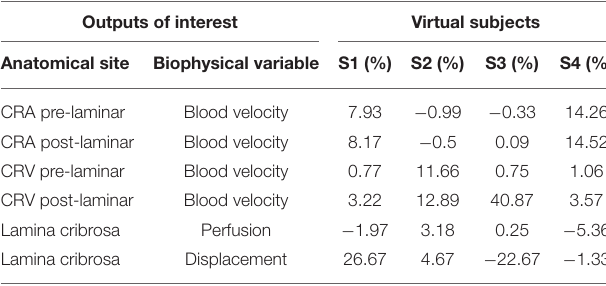
TABLE 2 | Summary of the maximum values of percent differences with respect to baseline in outputs of clinical interest for four virtual subjects as predicted by the Ocular Mathematical Virtual Simulator